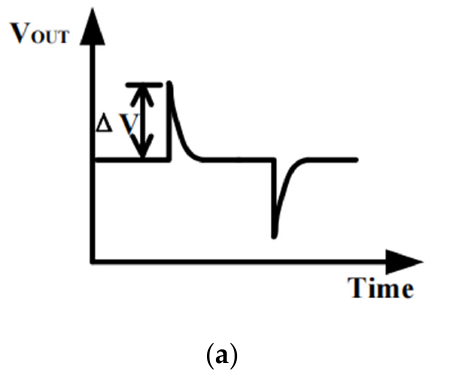
Figure 3. ( a ) Change in V OUT ; ( b ) Variation in I 1 and I 2 .